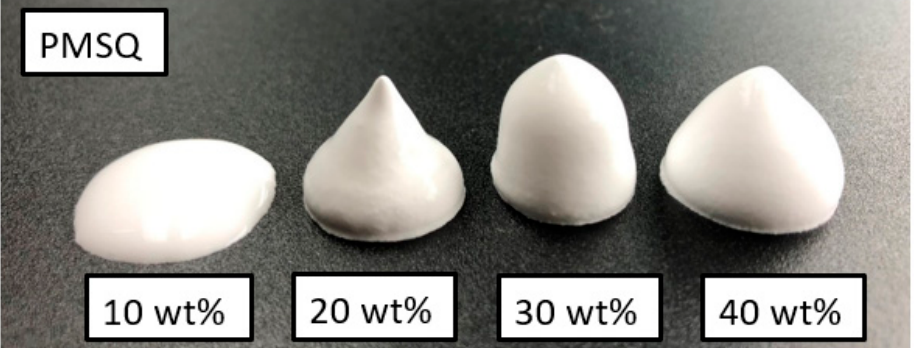
Figure 1. Slurries with 10, 20, 30 and 40 wt% PMSQ after 60 min of magnetic stirring.